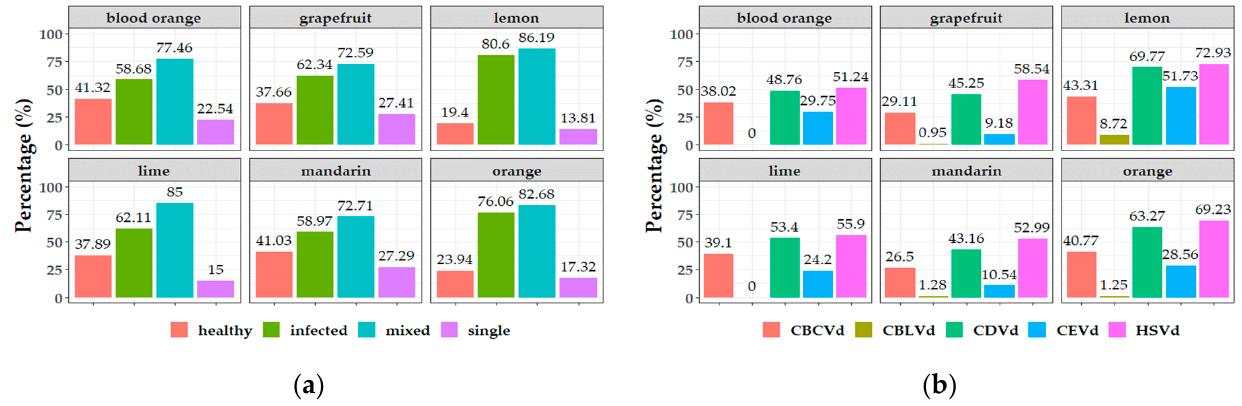
Figure 5. Phytosanitary status (healthy, infected, single, and mixed infected) in percentages (%) of the overall samples of each host collected from five districts in Greece ( a ). Frequency in percentages (%) of citrus viroids in six different hosts from the overall number of collected samples in Greece ( b